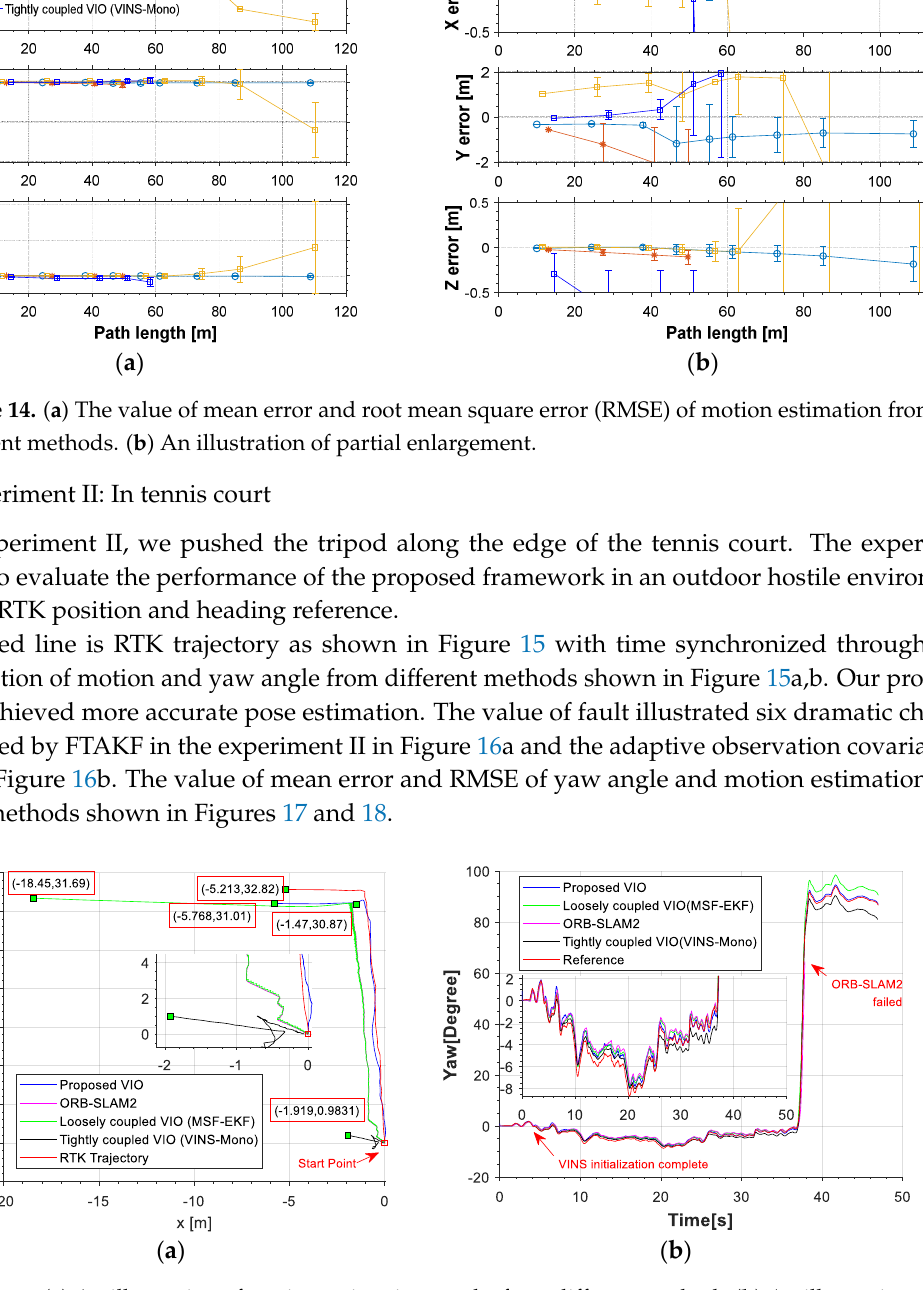
Figure 15. ( a ) An illustration of motion estimation results from different methods ( b ) An illustration of yaw angle estimated by different methods. (VINS-Mono without output before initialization).